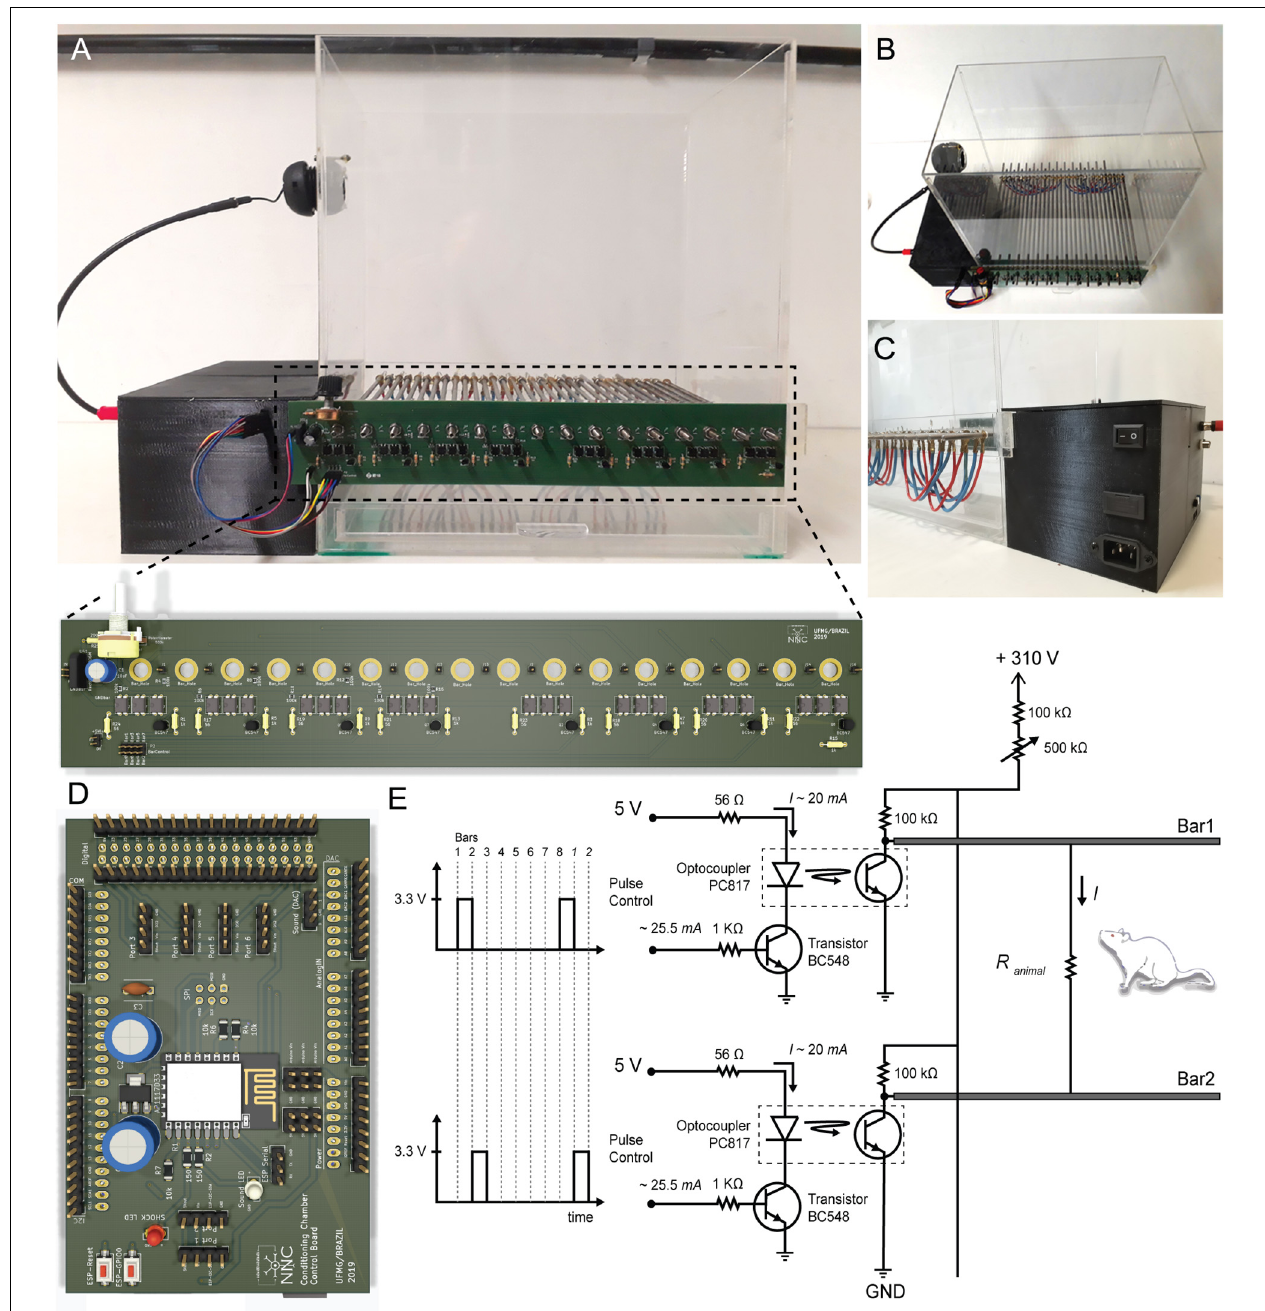
FIGURE 3 | Hardware Design. ( A , Top) Conditioning chamber front view. (Bottom) Two-layer printed circuit board with power circuit. Attached to the chamber via 16 mounting holes, this board allows creating electric potential between the conductive bars. (B,C) Up view and back view of the conditioning chamber respectively. Detail for black box built on the 3d printer where all electronic components are organized. (D) Two-layer printed circuit board with control circuit. It has ESP8266-12E footprint, Arduino Due shield and it outputs a low power audio waveform and digital signals with temporal patterns for electric stimulus control. (E) Electric potential on each bar is controlled through a switch (npn transistor operating in saturation mode). A set of optocouplers are used in order to isolate power circuit from control circuit. Output voltage is 0 V DC or 310 V DC . Output current ranges from ∼ 200 to ∼ 1500 µ A.